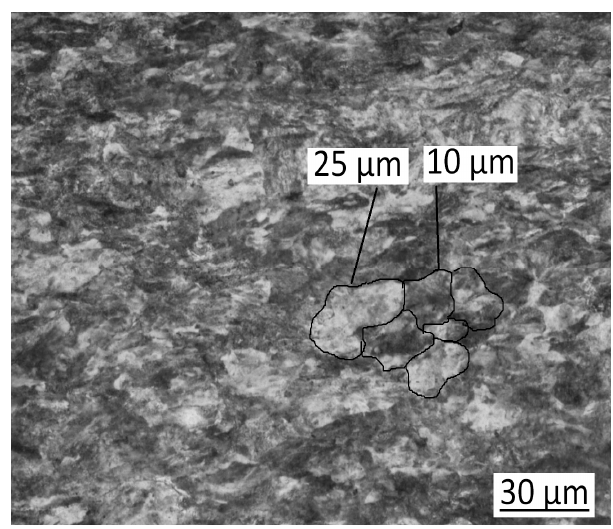
Figure 1. Microstructure of the wire material before multipass drawing, × 1000.